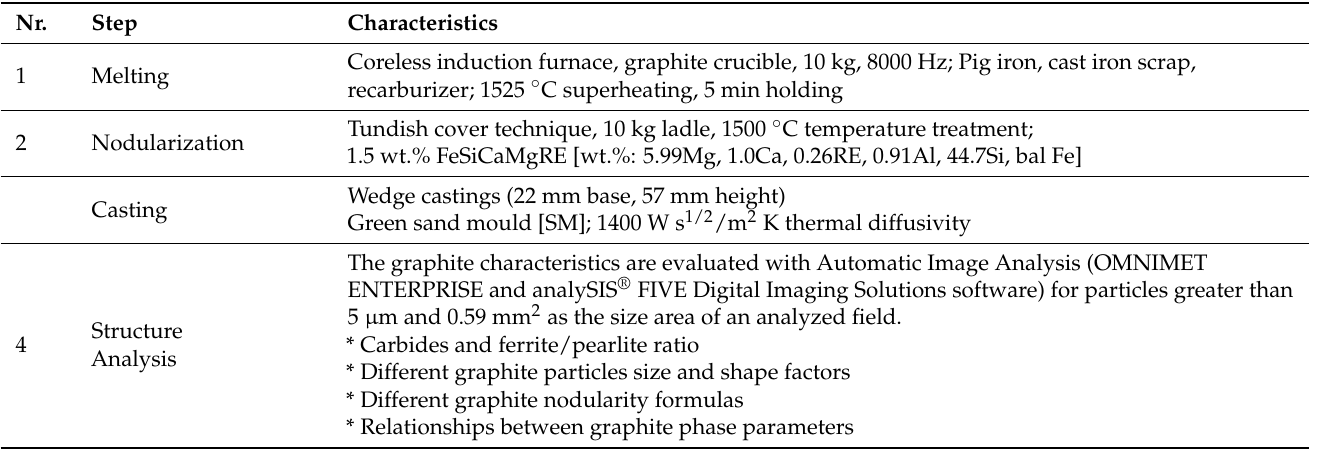
Table 1. Experimental procedure